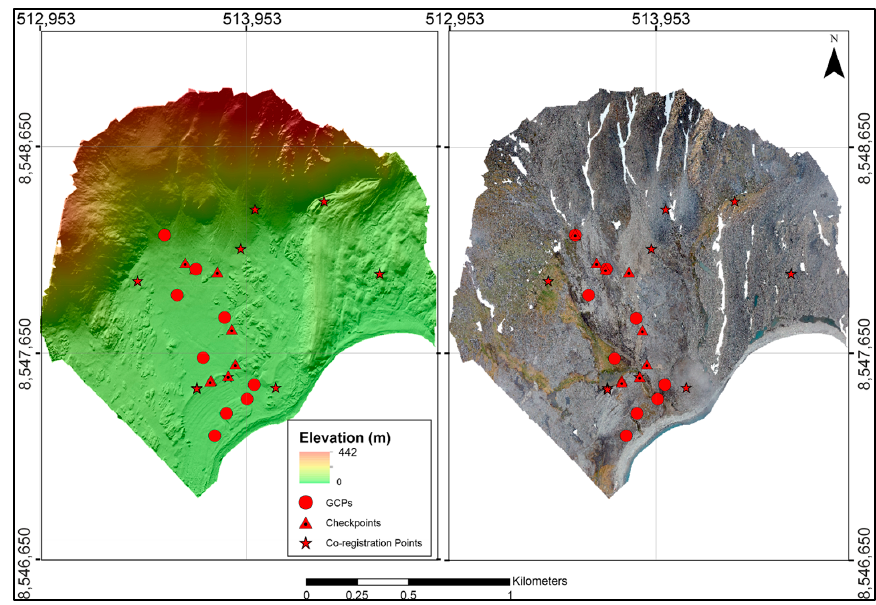
Figure 4. DEM and orthophotomap of the Fuglebekken catchment. The final resolution post-processing was 0.06 m, and it was geo-rectified by four ground control points (red dots) and co-registration points (red stars).